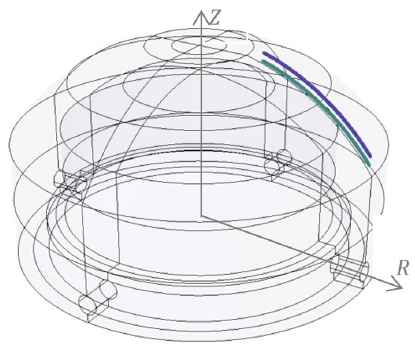
Figure 17. System of generatrices for the shape deviation distribution analysis.